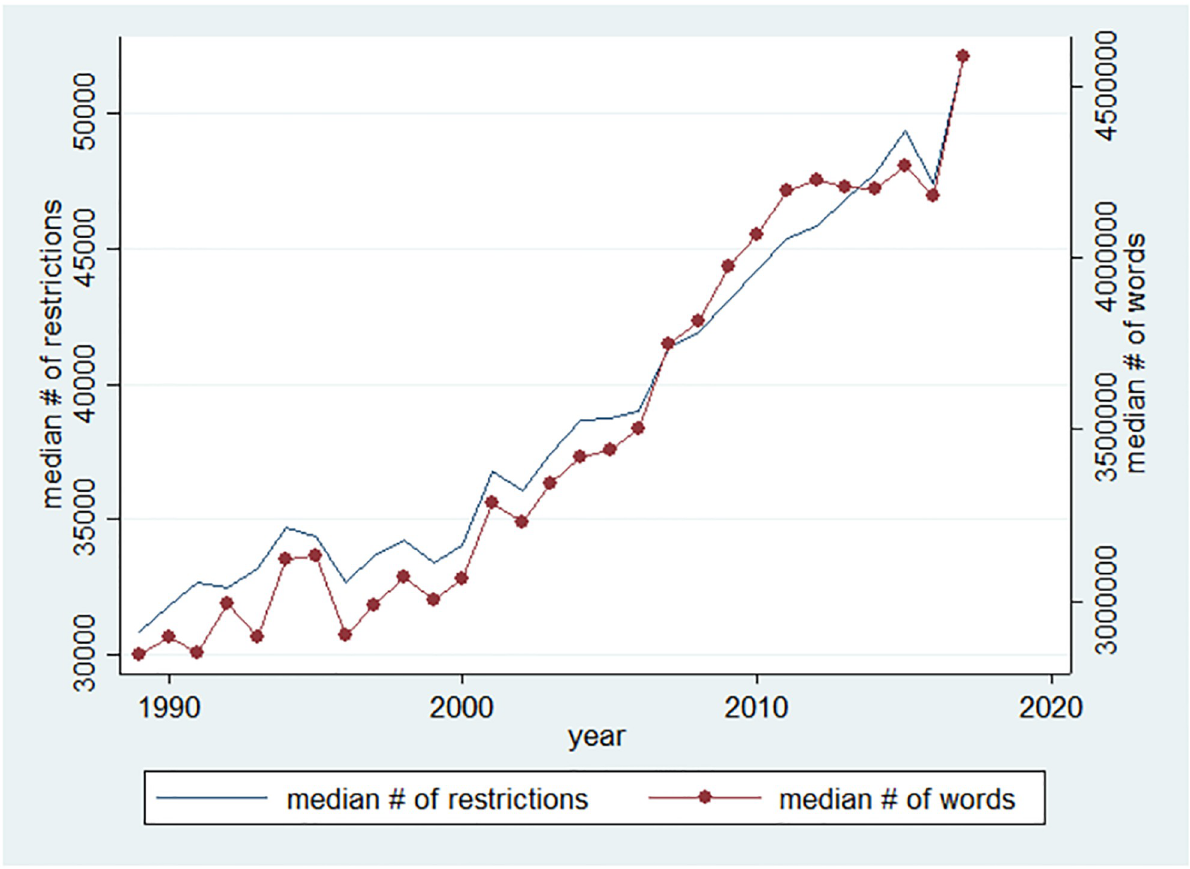
Fig 5. Entry regulation